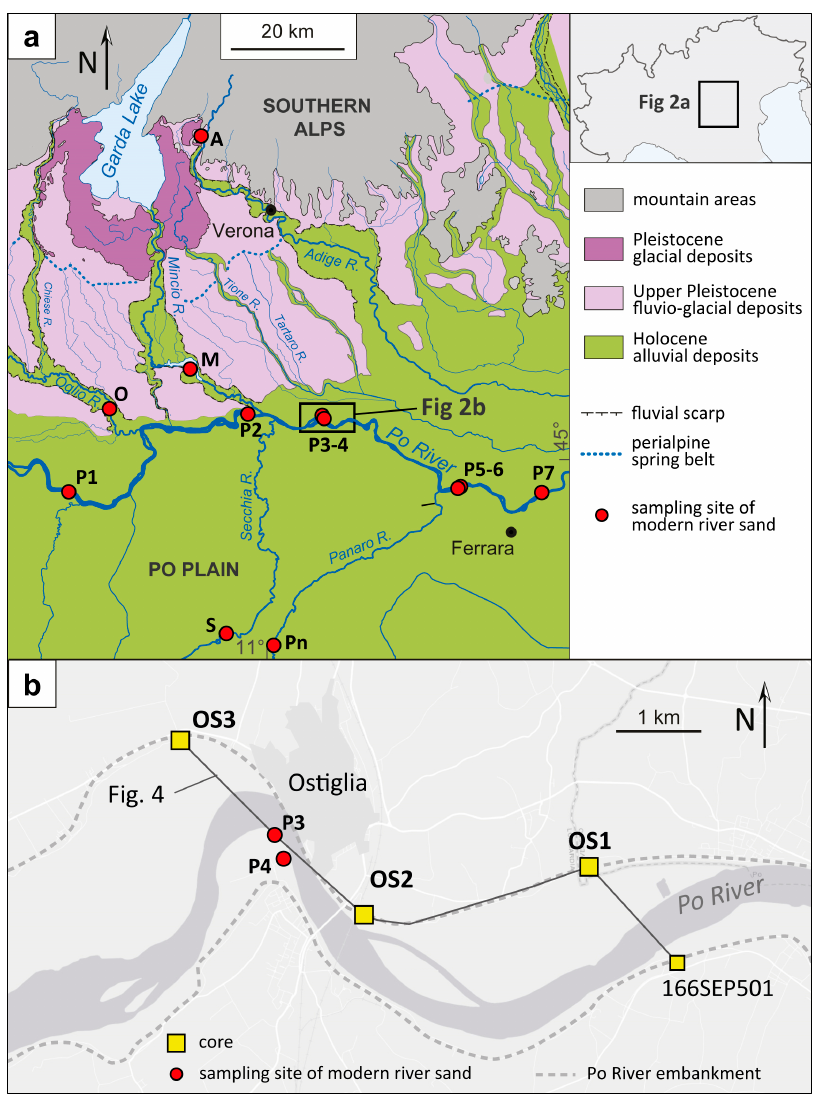
Figure 2. Location of study area. ( a ): Geological map of the Po Plain with location of the study area and of sampling sites of modern river sands (modified after [27]). ( b ): close-up on the study area with the locations of the analyzed cores.